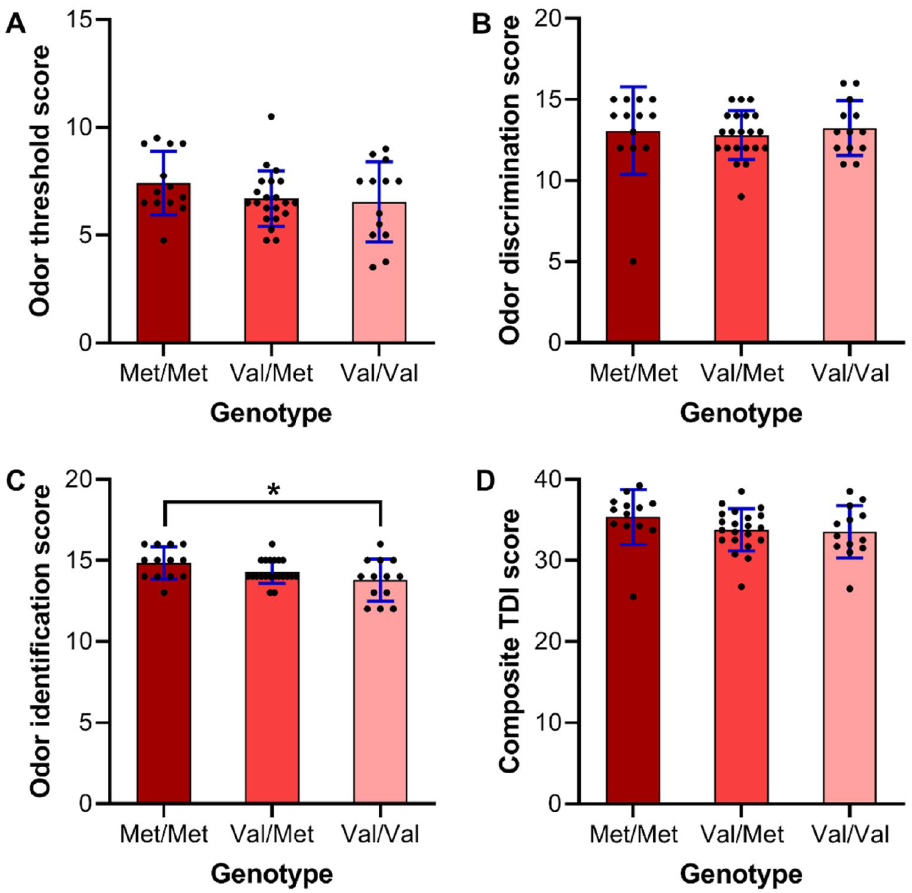
Figure 1. Differences in olfactory performance (by Sniffin’ Sticks test) among the three genotype groups in the olfaction cohort (n = 47). ( A , B , D ) No differences were noted in terms of odor detection threshold, discrimination, or composite TDI score. ( C ) The Met/Met group out-performed the Val/Val group in odor identification (post hoc Bonferroni test, * P = 0.023). A Met-allele dosage effect was observed (linear regression, r = 0.45, beta = 0.61, t = 3.02, P = 0.004, Supplementary Table 2). The bar graphs show the means and standard deviations of olfactory scores, and the scatter plots demonstrate all data